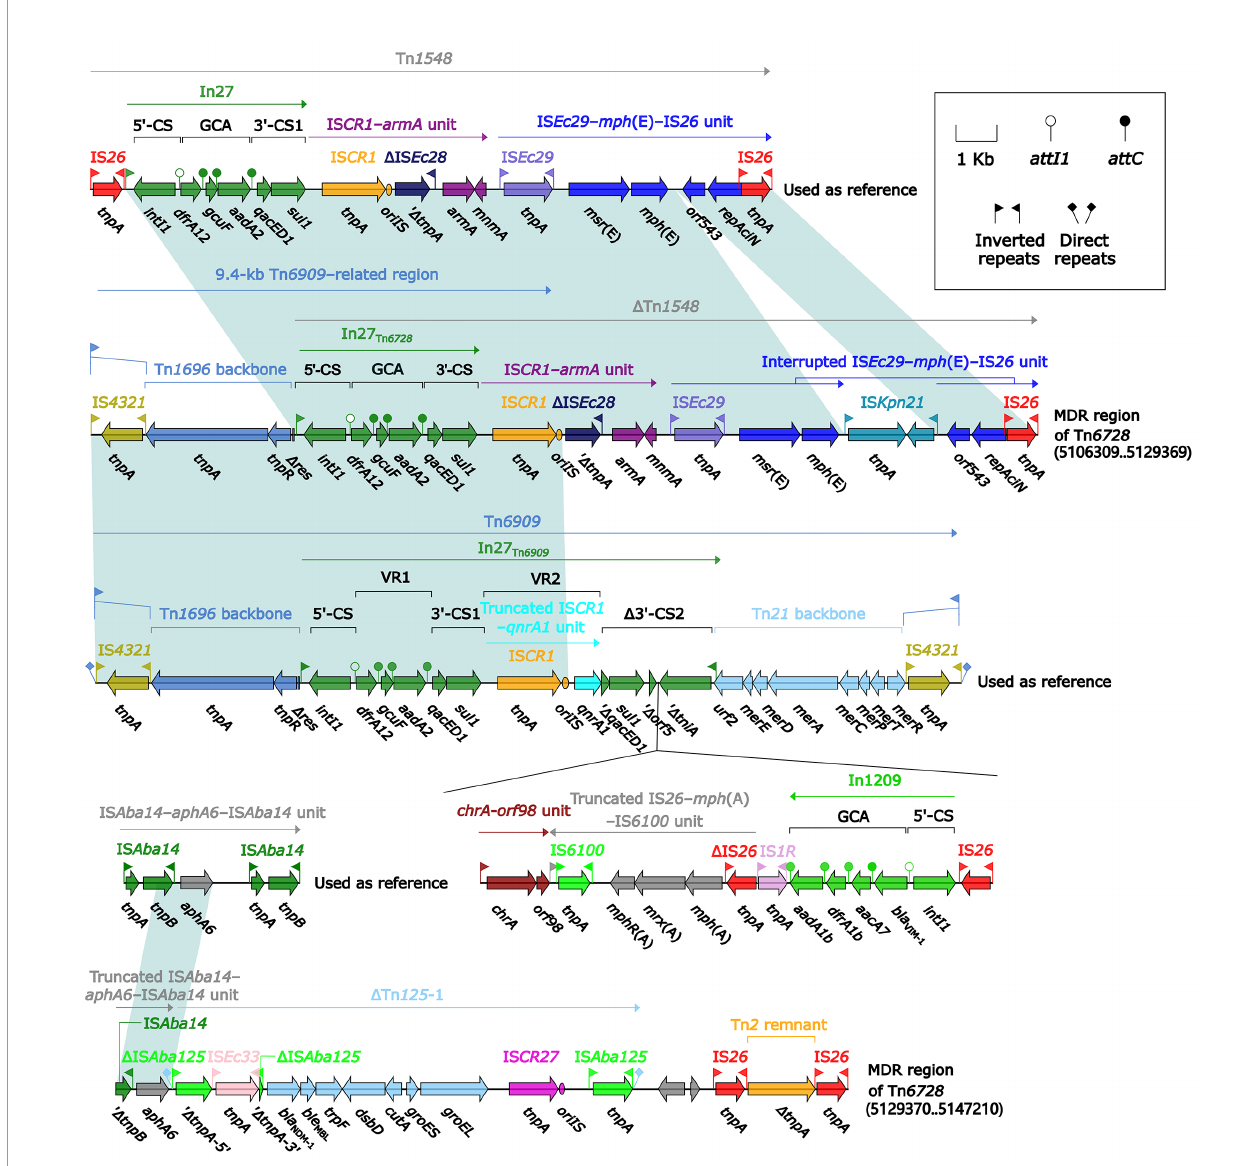
FIGURE 9 | Organization of MDR region from Tn 6728 , and comparison to related regions. Genes are denoted by arrows. Genes, mobile elements, and other features are colored based on their functional classi fi cation. Shading denotes regions of homology (nucleotide identity ≥ 95%). Numbers in brackets indicate nucleotide positions within the chromosome of strain KP64. The accession numbers of Tn 1548 (Galimand et al., 2005), Tn 6909 , and IS Aba14 – aphA6 – IS Aba14 unit used as reference are AF550415, CP032168, and CP046406,